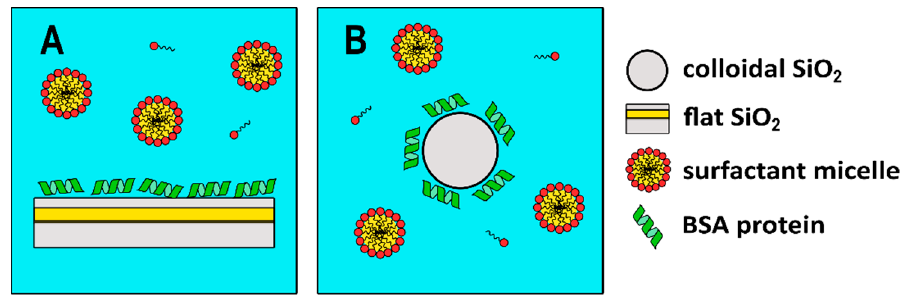
Scheme 1. Graphical representation of the interaction between bovine serum albumin (BSA)-coated SiO 2 and surfactant on both flat ( A ) and colloidal surfaces ( B ).